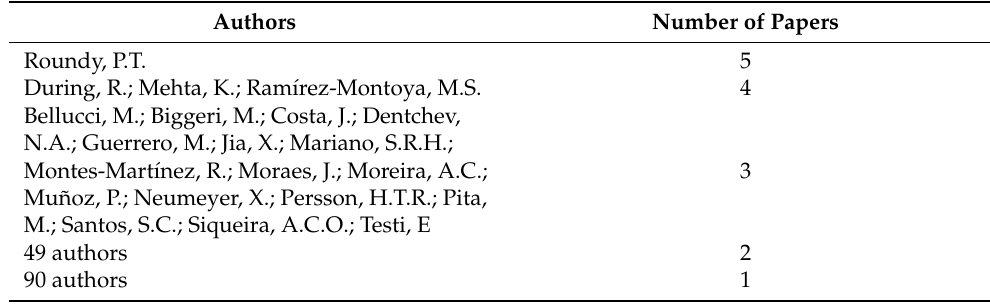
Table 3. Top authors in social entrepreneurship and entrepreneurial ecosystem. Source: own elaboration. Authors Number of Papers Roundy, P.T.